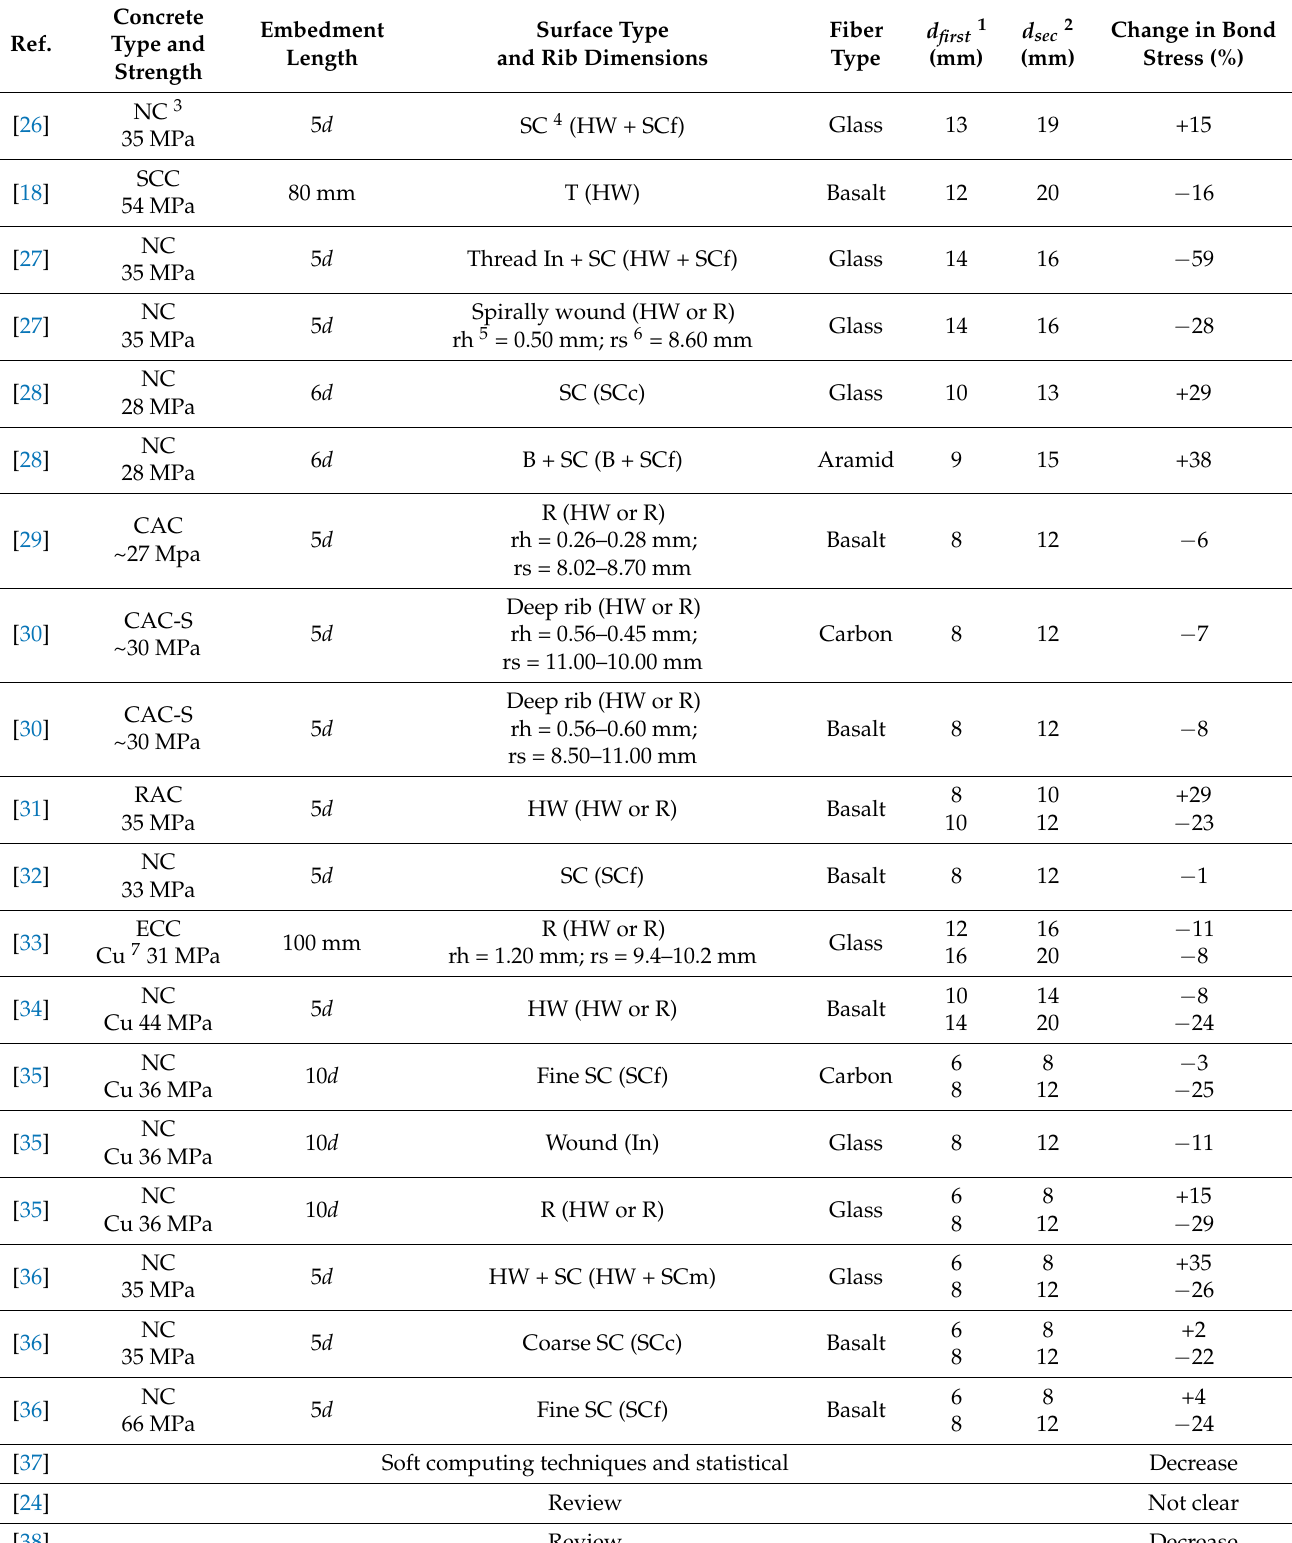
Table 1. Studies on the influence of bar diameter on FRP–concrete bond